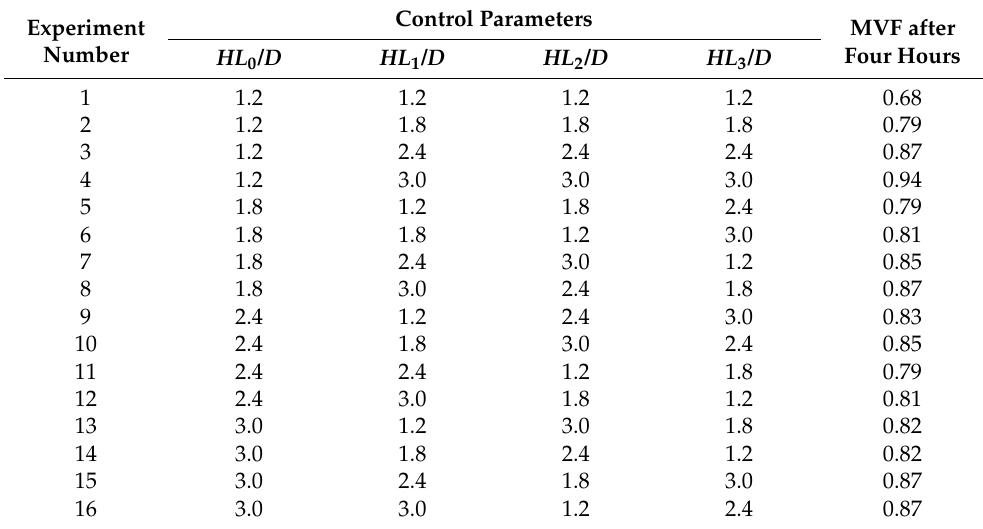
Table 3. L16 orthogonal table corresponding to range and levels of control